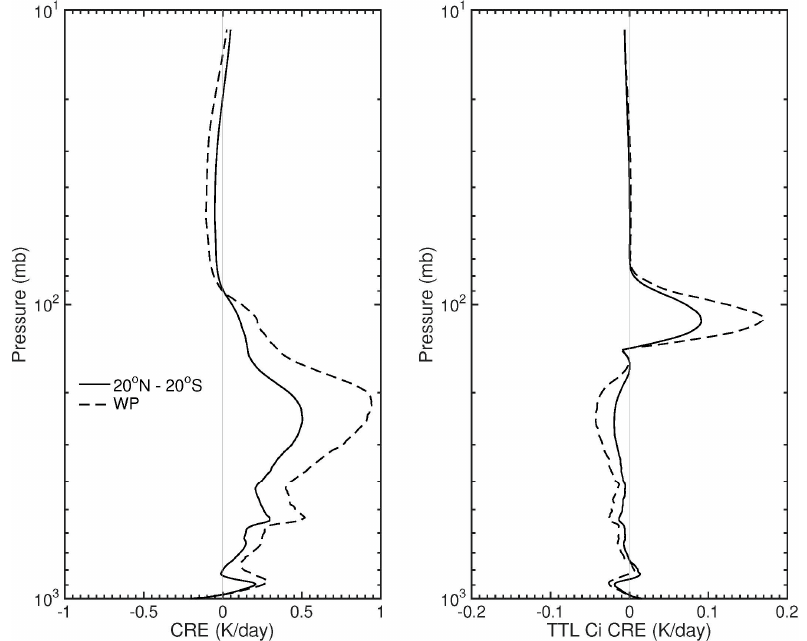
Figure 2. ( Left ) Cloud radiative effect (CRE) over the tropics (solid) and western Pacific (dashed). ( Right ) The same as left but for the TTL cirrus cloud radiative effect.